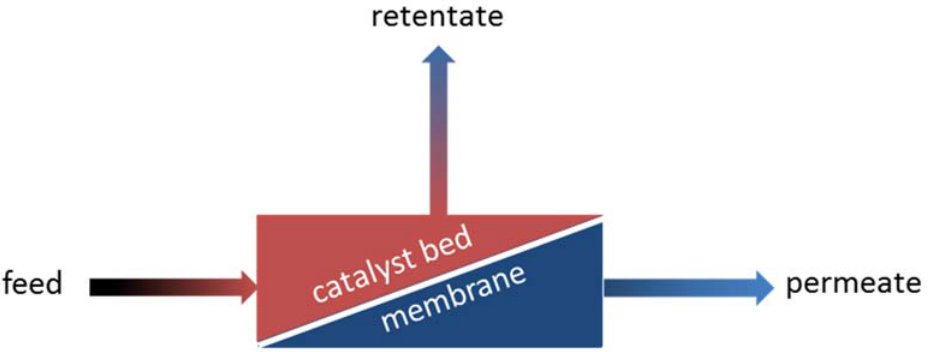
Figure 4. Schematic drawing of a packed bed membrane reactor